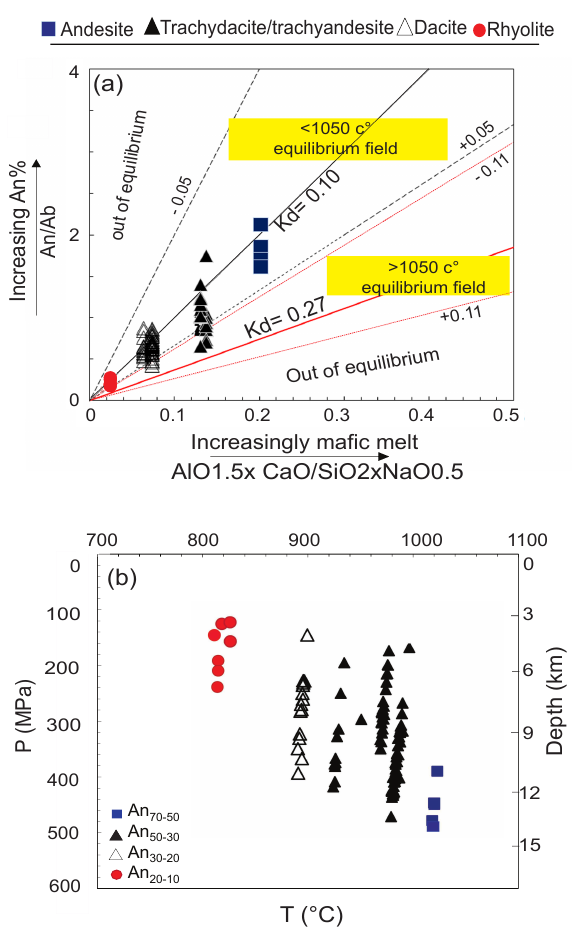
Fig. 14 Figure 14. (a) Equilibrium test for plagioclase and four pos- sible melts. The andesite samples appear to be in equilibrium with high anorthite plagioclase (An 70 − 50 ), while the trachyan- desite/trachydacite and dacite are in equilibrium with (An 50 − 30 ) and (An 30 − 20 ), respectively. Rhyolite, in turn, is in equilib- rium with low anorthite plagioclase (An 20 − 10 ). (b) Results of plagioclase–melt thermobarometry after (Putirka, 2008). SEE for the plagioclase–melt thermobarometer are ± 36 ◦ C and ± 247MPa. makitic clots suggest corresponding H 2 O melt values between 5.5 to 9.3 wt % ( ±